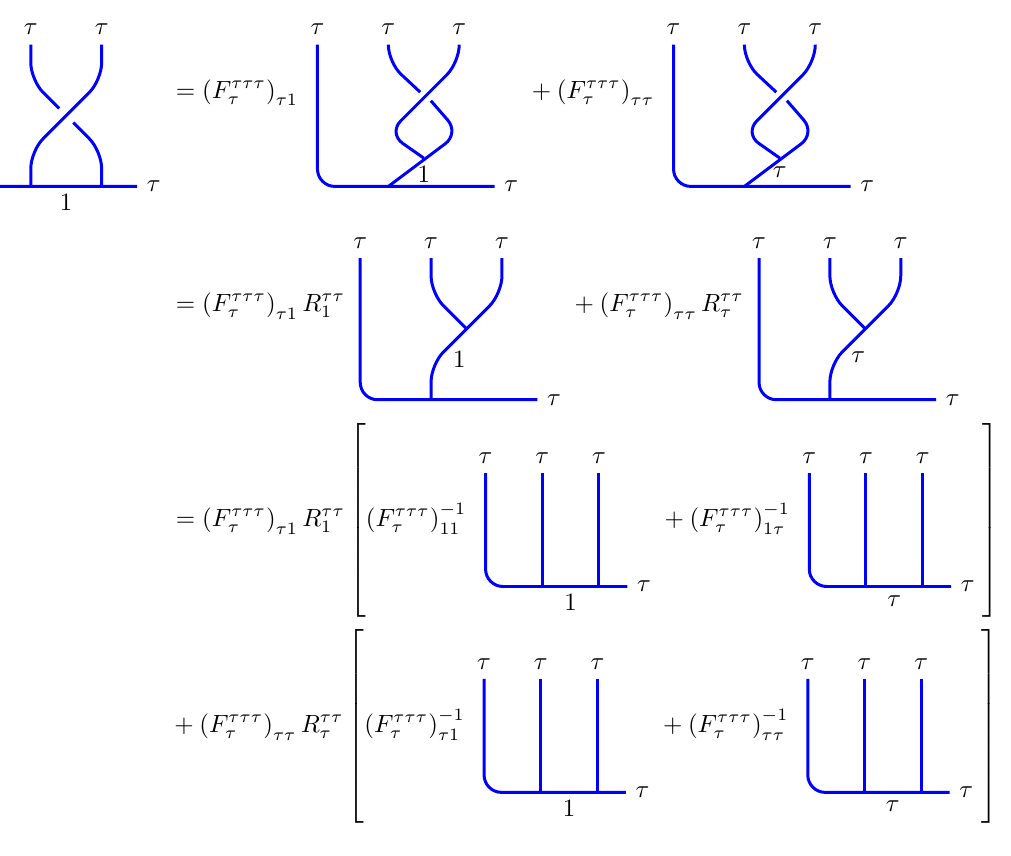
Figure 14 . Action of σ 2 ∈ B 3 on the fusion basis vector | τ i . The elements of the F -matrix are in